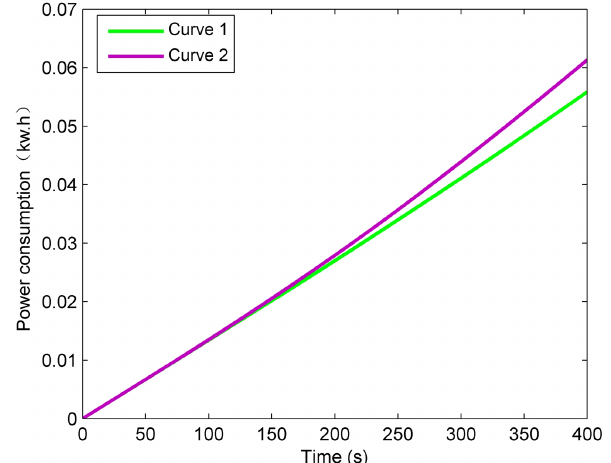
Figure 15. Temperature rising curves of the braking disc under dif- ferent braking situations.